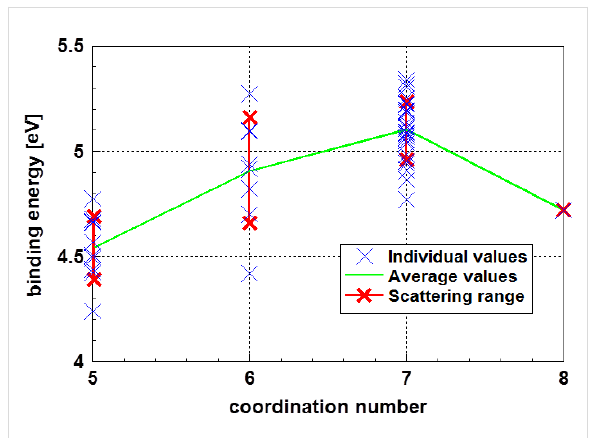
Figure 18: Binding energy of the atoms in the outmost layer of an Au 55 cluster [14]. Additionally, for each coordination number, the 1 σ scat- tering range is indicated. The atoms with the highest probability to be evaporated are those with the smallest coordination number and the smallest binding